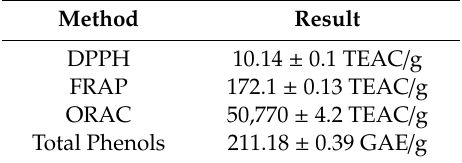
Table 1. Antioxidant activity of methanol extract of L. tridentata